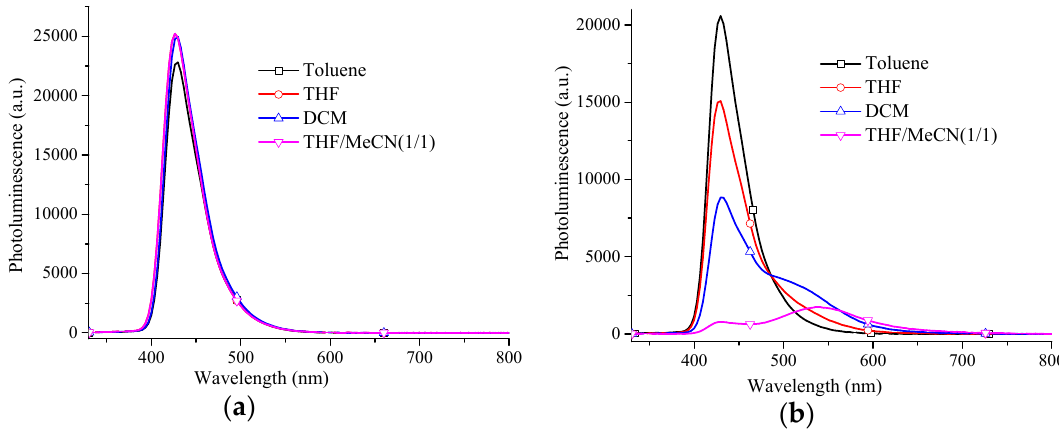
Figure 3. PL spectra of D1 ( a ) and D2 ( b ) in different solvents (excited at 319 nm, 3.5 × 10 − 6 M ( a ); 4.0 × 10 − 6 M ( b )).